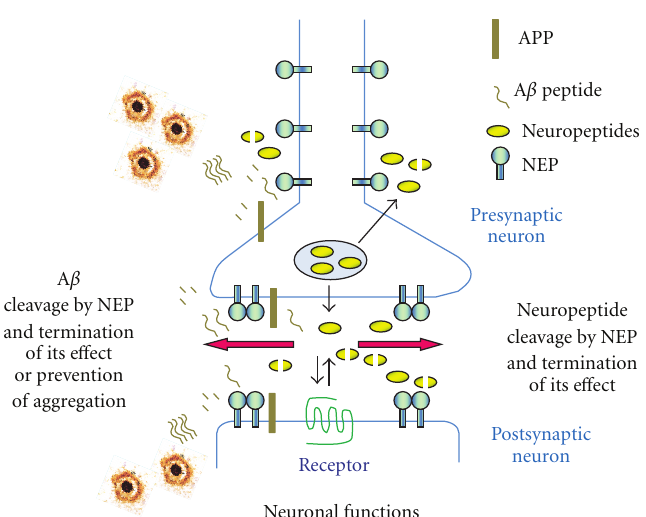
Figure 1: Schematic presentation of NEP localization and functional activity in the brain. NEP being localised pre- and postsynaptically in neuronal cells cleaves its neuropeptide substrates (including A β ) terminating their properties and as such regulating cellular response to their action and neuronal functions. In the case of A β , NEP also prevents accumulation and aggregation of toxic amyloid oligomers. All symbols are explained in the figure.